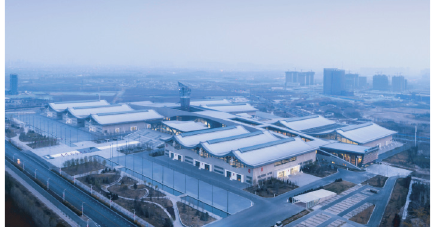
Figure 6: Completion of the